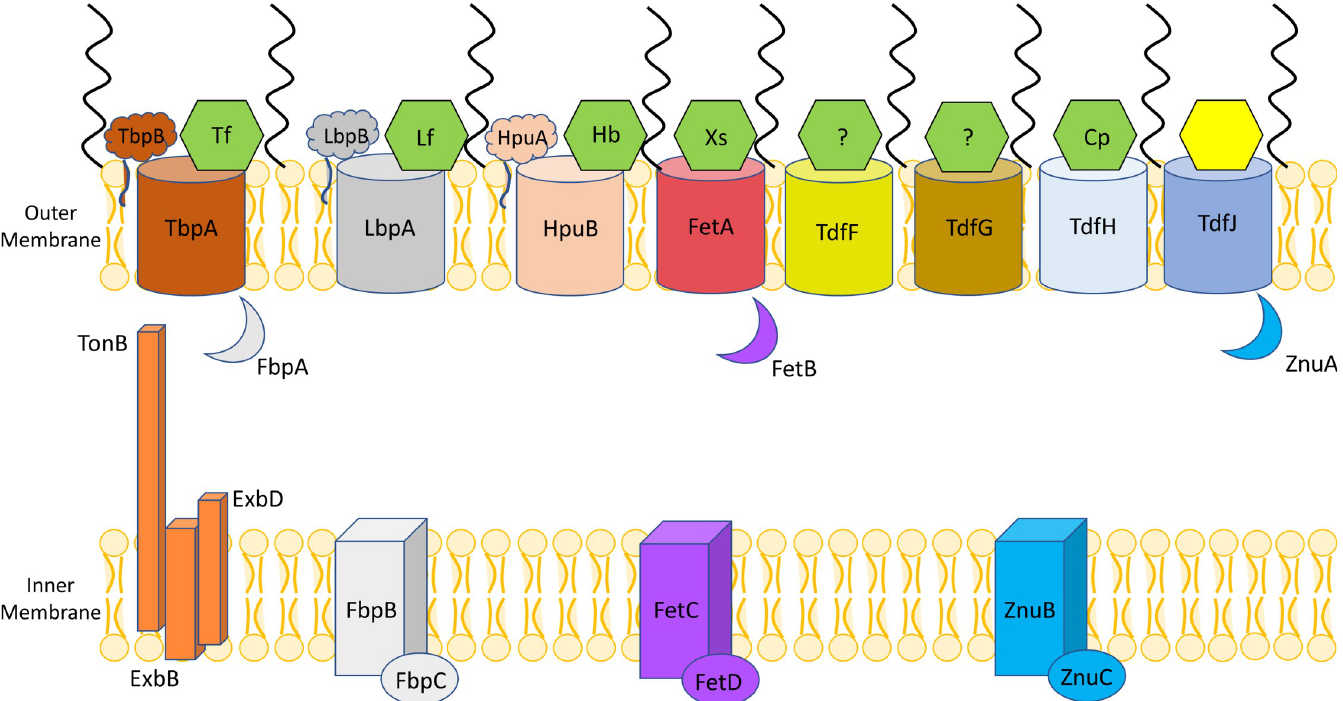
Fig 1. TonB-dependent transporters, surface-tethered lipoproteins, and ABC transport systems produced by Neisseria gonorrhoeae . Cartoon schematics of the eight known TdTs produced by the gonococcus are represented by barrel shapes in the outer membrane, and their respective ligands identified to date, shown by green hexagons. The ligand for TdfJ, which is the focus of this manuscript, is highlighted in yellow. Also illustrated are the lipoprotein components associated with TbpA, LbpA, and HpuB, shown here anchored to the outer membrane. TonB, ExbB, and ExbD, which utilize the proton motive force to energize the transport of cargo through the outer membrane via the TdTs are shown in the left-hand side of the inner membrane. Black squiggles on the outer leaflet represent lipooligosaccharide. Lastly, the cognate ABC transport systems associated with the TdTs are shown in the inner membrane and the periplasmic space. FbpABC transports ferric iron, FetBCD transports catecholate-type siderophores, and ZnuABC (also called MntABC elsewhere in the literature) transports zinc and manganese. Ligands: Tf = Transferrin; Lf = Lactoferrin; Hb = Hemoglobin; Xs = Xenosiderophore; Cp = Calprotectin.